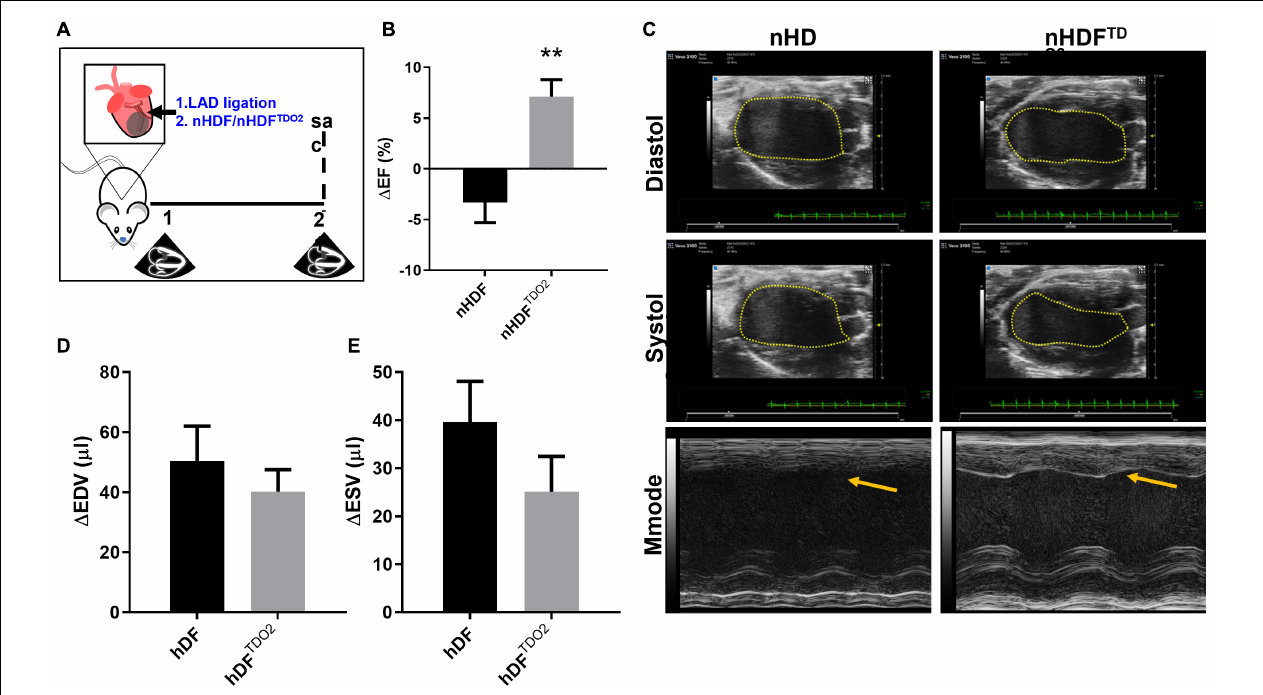
FIGURE 5 | Neonatal human fibroblasts transduced to overexpress TDO2 increase ejection fraction in a 3-week mouse model of MI. (A) In an acute model of MI, BL6 mice underwent MI and hearts were injected with nHDF cells ( n = 10) and nHDF TDO2 cells ( n = 8). (B) Treatment with nHDF TDO2 cells increased ejection fraction in mice 21-day post-infarct. (C) Representative B-mode images of systole and diastole illustrating the ventricular-volume tracing method used to measure ejection fraction. M-mode images of left ventricular contraction. Improved contraction in the left ventricular wall after treatment with nHDF TDO2 cells is observed by the inward contraction of the left ventricular wall (yellow arrow). (D) Average change in left ventricular end-diastolic volumes. (E) Average change in left ventricular end-systolic volume. Statistical analysis was done using an unpaired t -test. ** p <